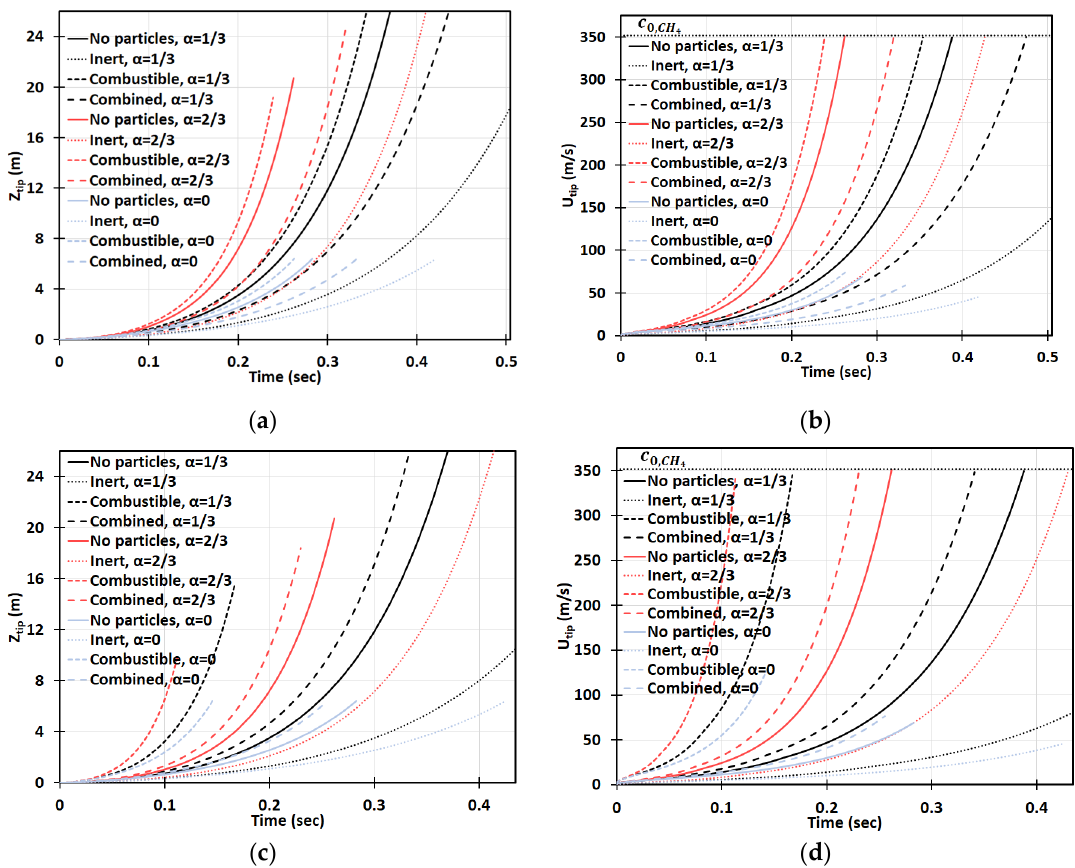
Figure 14. Time evolution of the flame tip position Z tip ( a , c ) and velocity U tip ( b , d ) in a 2D ( a , b ) and cylindrical-axisymmetric ( c , d ) geometries for lean CH 4 -air burning of φ = 0.7, without and with dust particles (combustible, inert, and combined) of particle radius r s = 75 µ m and concentration c s = 120 g/m 3 , for various blockage ratios, α =